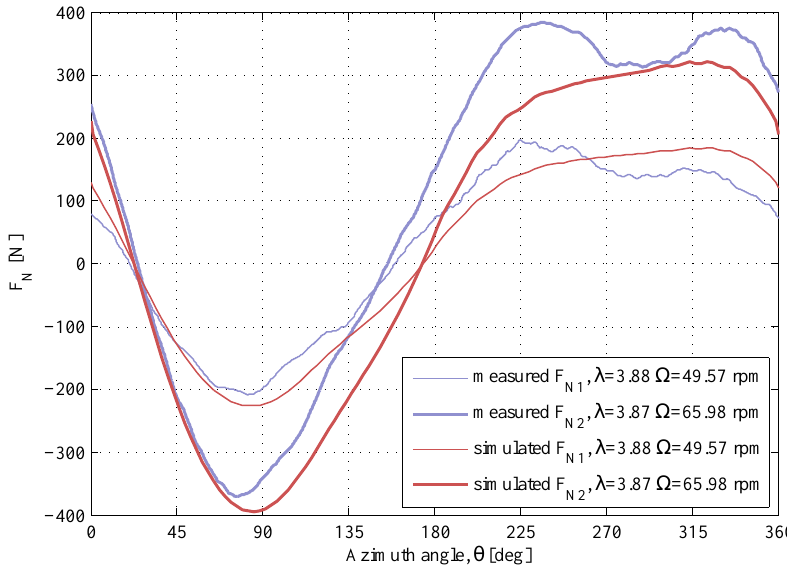
Figure 15. The normal forces at the similar λ and different Ω . The air densities and the kinematic viscosities are ρ ν = 1 . 43 · 10 − 5 m 2 / s . 2